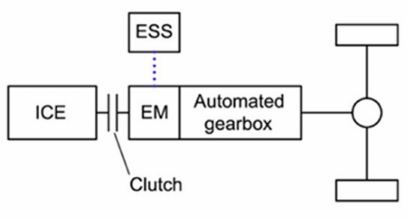
Figure 2. Parallel hybrid powertrain topology with a stepped automated gearbox. EM: Electric machine, ESS: Energy storage system, ICE: Internal combustion